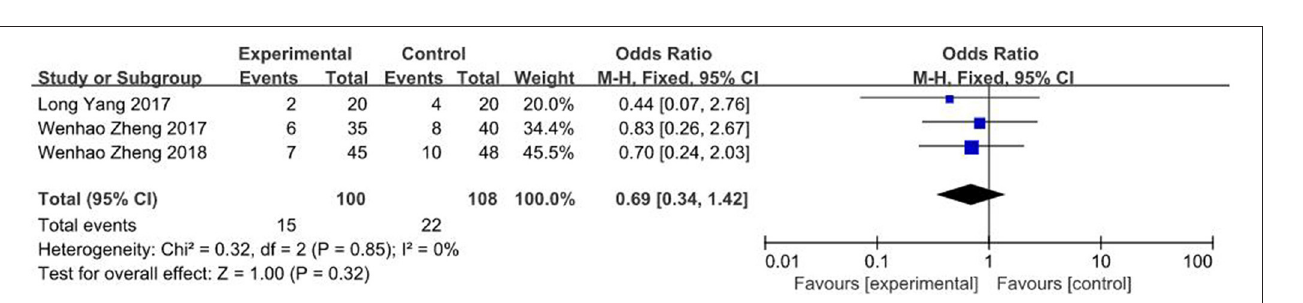
FIGURE 8 | Meta-analysis results of the rate of excellent outcomes.